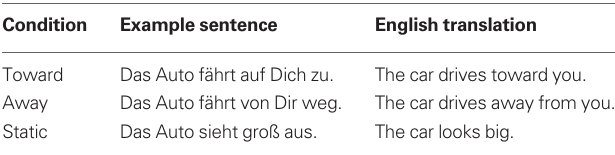
Table 1 | Examples of the sentences used in Experiment 1 with English